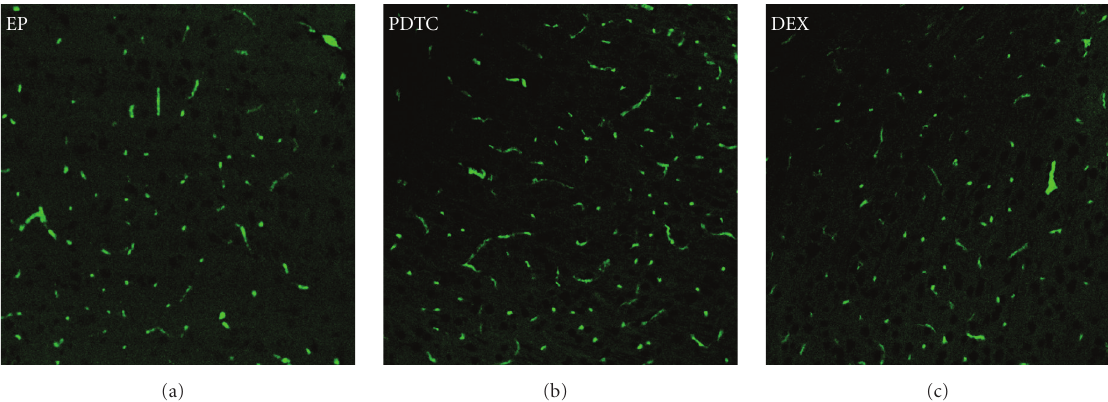
Figure 5: Pretreatment of PDTC and DEX did not change endothelial cell numbers compared with EP group. Representative photos of immuno-staining with anti-GLUT1 antibody ( × 200). Endothelial cells in the rat brains of each group were labeled with an anti-GLUT1 antibody paired with a FITC conjugated secondary antibody (shown in green). No significant di ff erence in endothelial cell numbers could be detected between PDTC/DEX and EP